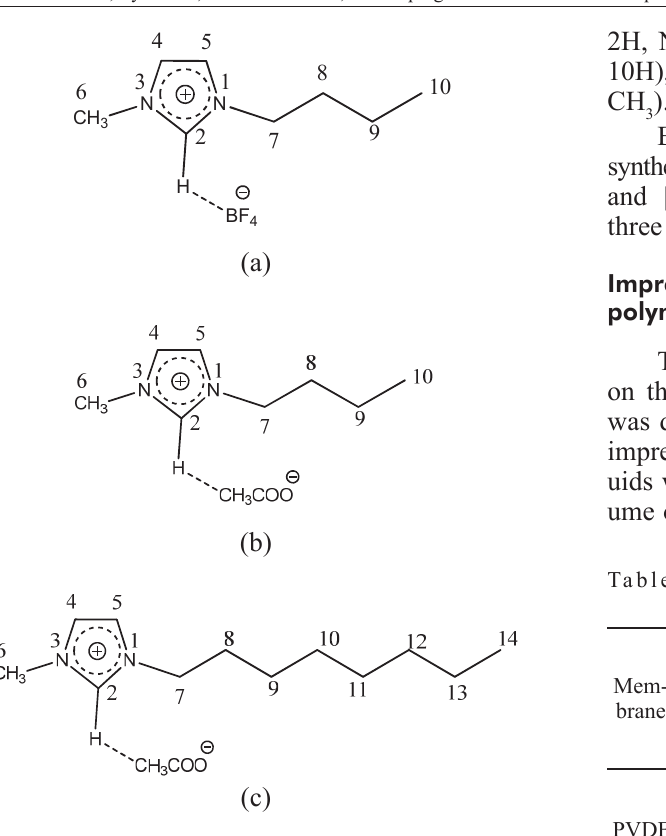
Fig. 2 – Structure of synthesized ionic liquids (a: [BMIM][BF b: [BMIM][CH